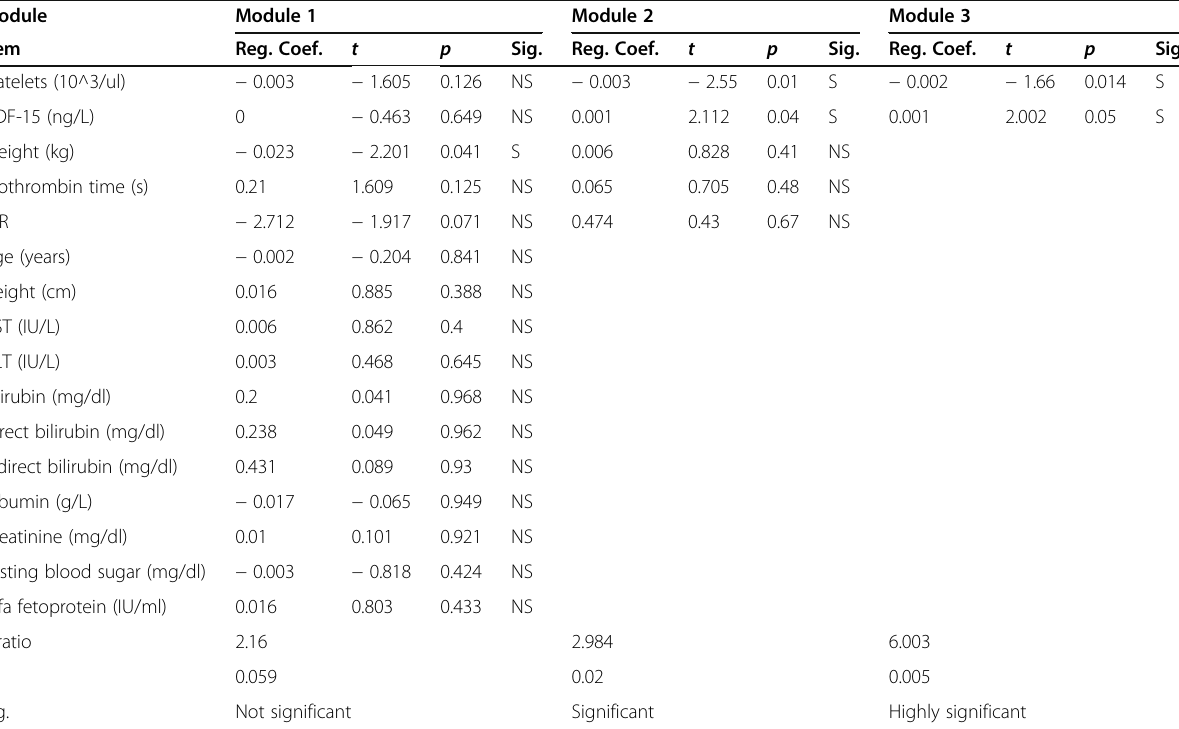
Table 4 Three models of logistic multi regression analysis used to predict the most sensitive predictors of liver fibrosis Module Module 1 Module 2 Module 3